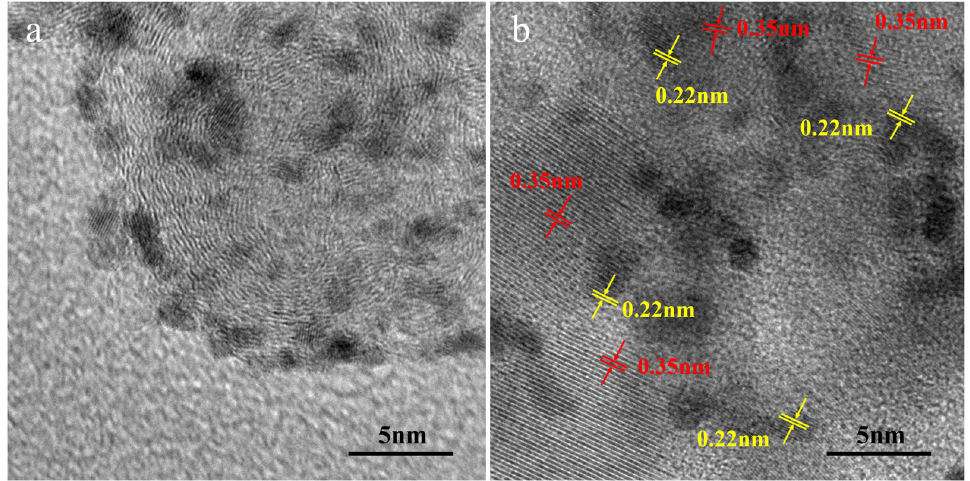
Figure 2. ( a ) TEM images of Pt/C and ( b ) Pt/C-20TiO 2 catalysts. The results show that the addition of TiO 2 has little effect on the ECSA of the Pt/C catalyst. Compared with that of Pt/C, the current peak, representing the oxygen reduction of the Pt/C-TiO 2 catalysts, shifts positively when TiO 2 ≤ 30%; Pt/C-20TiO 2 has the most positive oxygen reduction peak, which likely indicates the best ORR activity, consistent with the LSV results in Figure 3b. The activity towards ORR is improved by increasing TiO 2 content and then started to decrease after reaching a maximum value, i.e., Pt/C-20TiO 2 . Too much TiO 2 ( ≥ 30 mass %) hinders the ORR activity, which is due to the low electron conductivity of TiO 2 . On the other hand, the half-wave potential ( E 1/2 ) of Pt/C-20TiO 2 is 0.867 V, presenting an increase by 0.014 V compared with Pt/C (0.853 V), and the i k @ 0.9 V is 2.337 mA/cm 2 , 20.5% higher than Pt/C (1.939 mA/cm 2 ). Based on the Koutechy– Levich (K–L) equation (see Section 3.3), the ORR polarization curves of Pt/C-20TiO 2